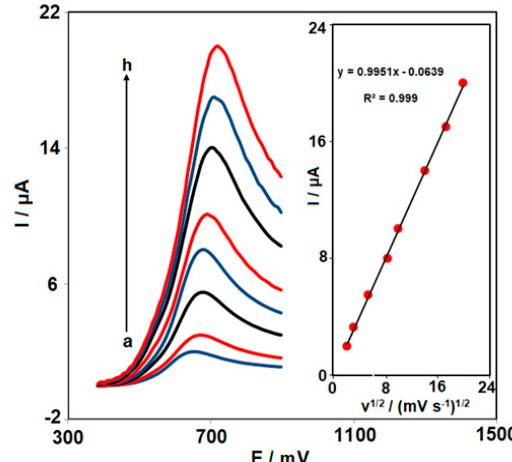
Figure 6. LSVs captured for the oxidation of KTC (50.0 μ M) on the Ce-BTC MOF/IL/CPE under variable scan rates (a–h: 5, 10, 30, 70, 100, 200, and 400 mV/s). Inset: the correlation of I pa with v 1/2 .